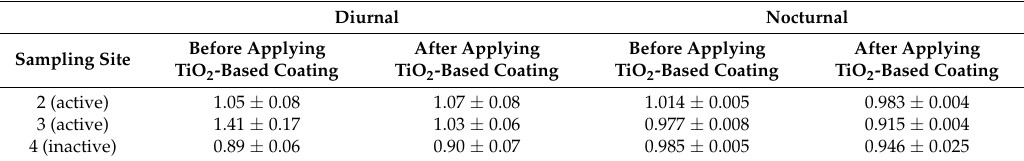
Table 13. Slopes from correlation plots of NO data (ppb ± 1 σ ) from three sampling sites (two active, one inactive) against inactive Site 1 for NO concentrations before and after implementation of the photocatalytic coating.